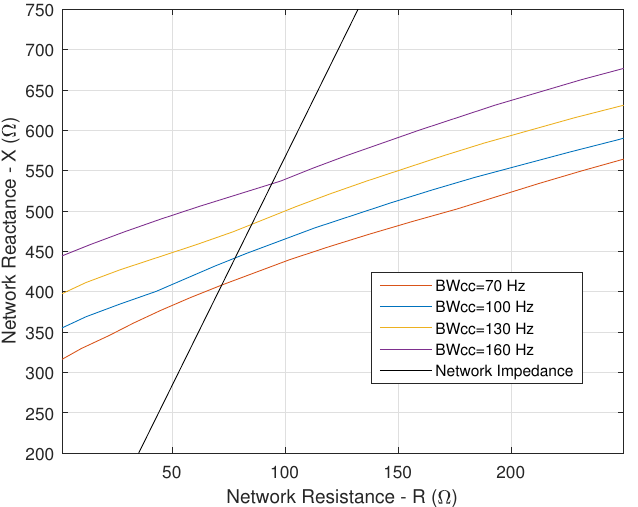
Figure 11. Stability limit curve of a traction chain in the network reactance ( X ) and resistant ( R ) complex plane. Variation of current controller